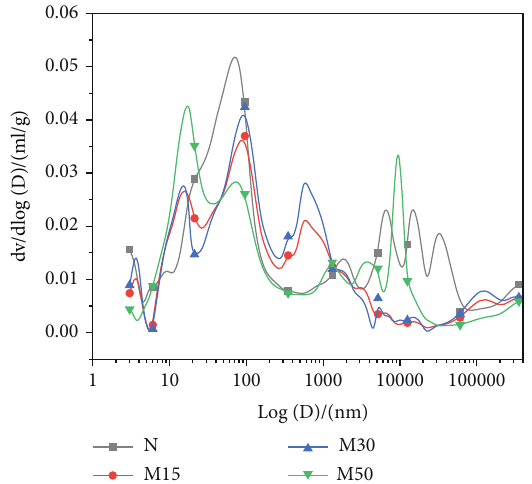
Figure 6: Variation of electrical conductivity of MWCNTs/CM with water content and MWCNTs